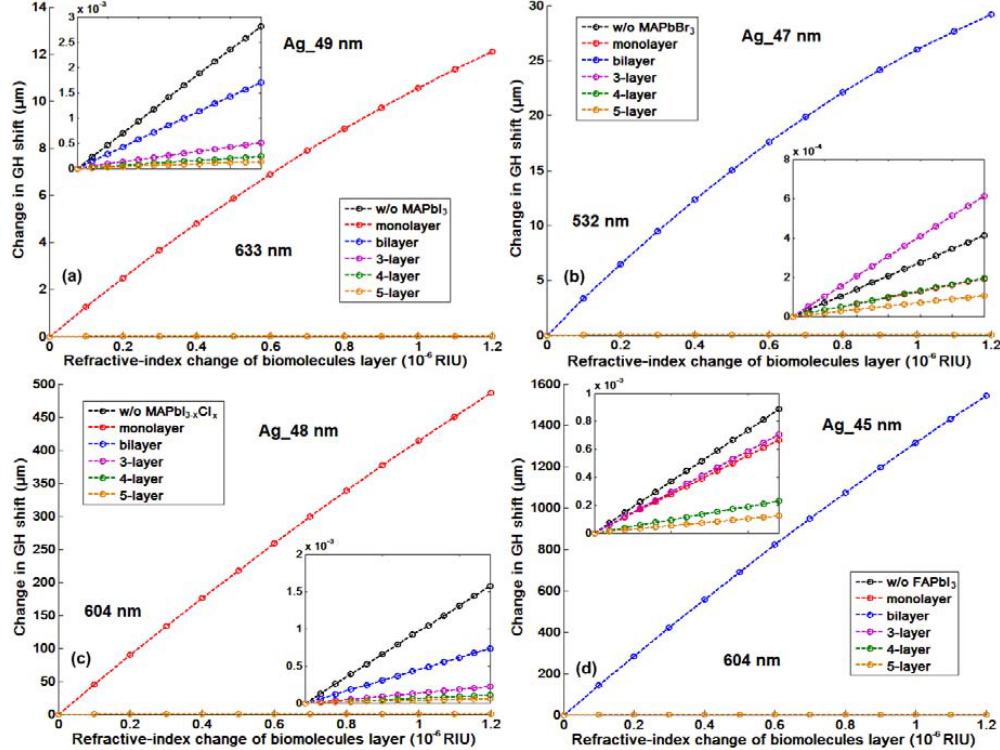
Figure 7. The linear Goos–Hänchen (GH)-SPR signal changes for sensing the target biomolecular binding enhanced by four different types of 2D perovskites: ( a ) MAPbI 3 , ( b ) MAPbBr 3 , ( c ) MAPbI 3 − x Cl x to ( d ) FAPbI 3 , with optimized silver substrate thickness and excitation wavelengths.